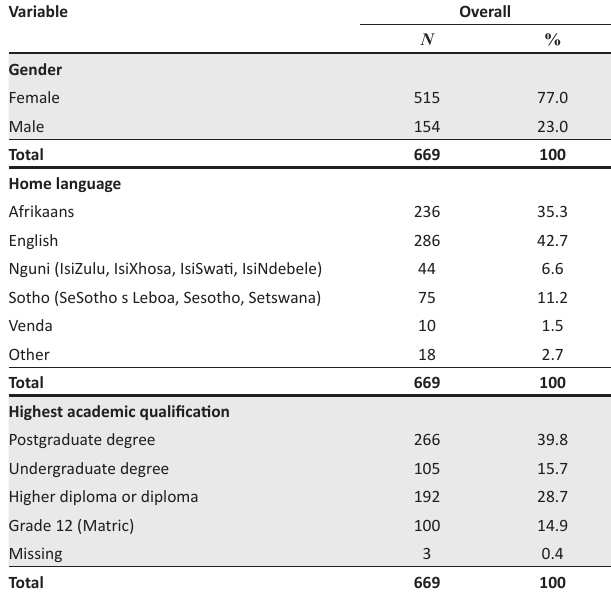
TABLE 1: Cronbach’s alpha coefficients for constructs.